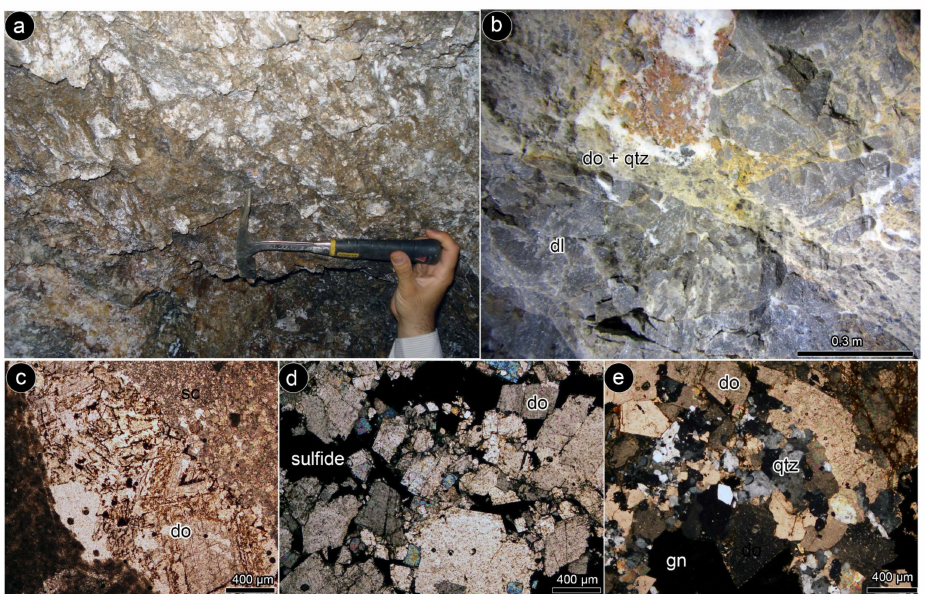
Figure 11. Outcrop ( a , b ) and microscopic (( c ) ppl, ( d , e ) xpl) photographs of hydrothermal dolomite (dolomitization) and silicification in a brecciated host rock of the Ab-Bid deposit; do: dolomite, qtz: quartz, gn: galena, dl: dolomitized